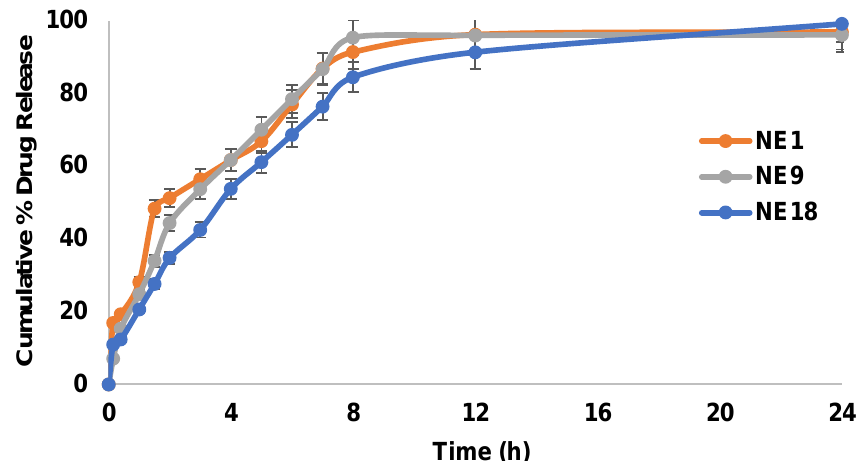
Figure 4. In vitro release of TAM from the TAM-loaded NE (nanoemulsion) system; data represent mean ± SD ( n = 3).